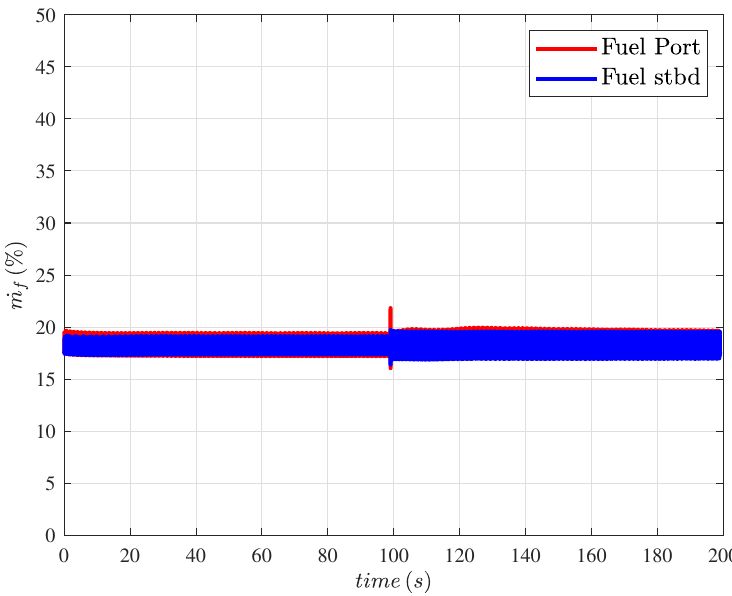
Figure 15. Fuel flow time